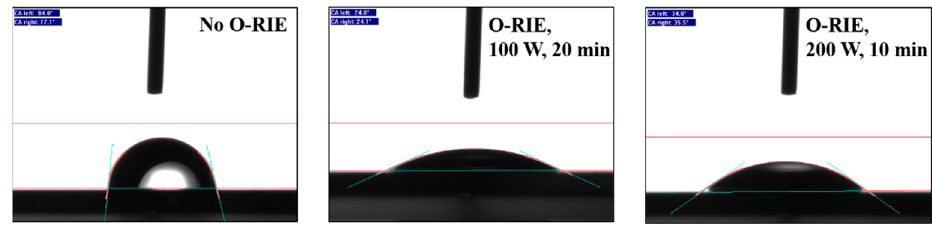
Figure 9. Contact angle measurements, respectively, for sample surfaces without O-RIE (left), with 100 W O-RIE (middle), and 200 W O-RIE (right) processes.